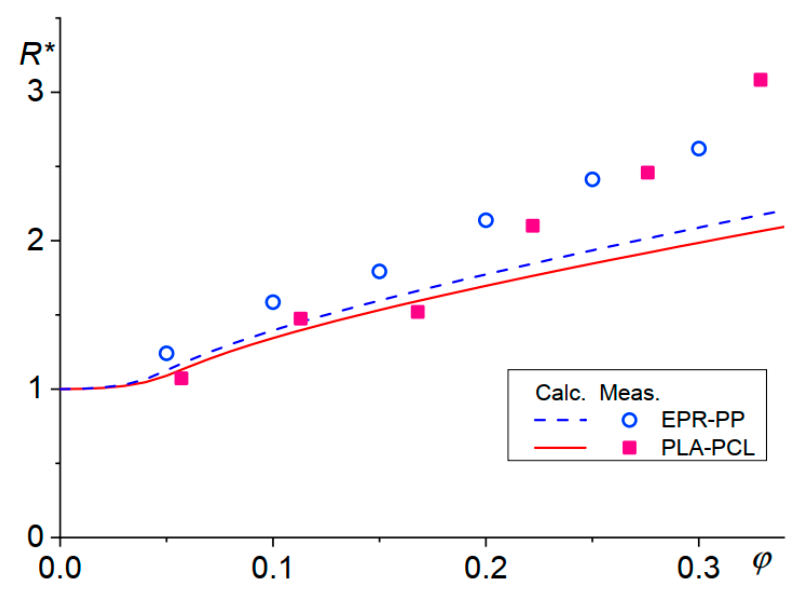
Figure 4. Reduced droplet sizes calculated using Equation (24) and the experimental sizes for blends ethylene-propylene rubber (EPR)-polypropylene (PP) [27] (dashed line and empty circles) and poly(lactic acid) (PLA)-poly(caprolactone) (PCL) [28] (solid line, full squares).